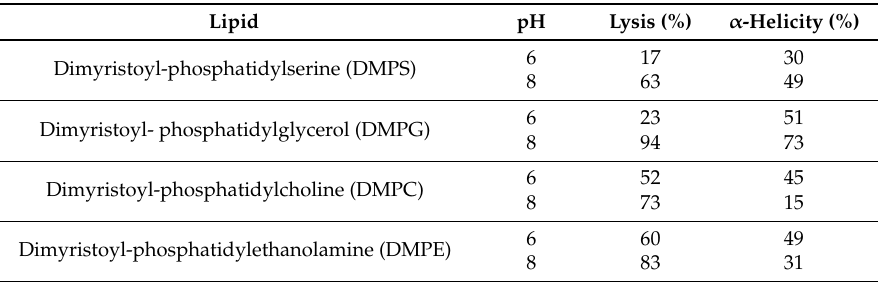
Table 4. The α -helical content and lysis levels of